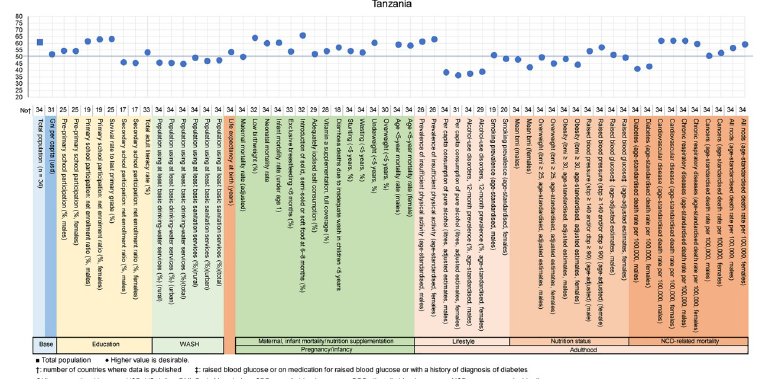
Fig 10. Country diagnosis by the deviation graph for